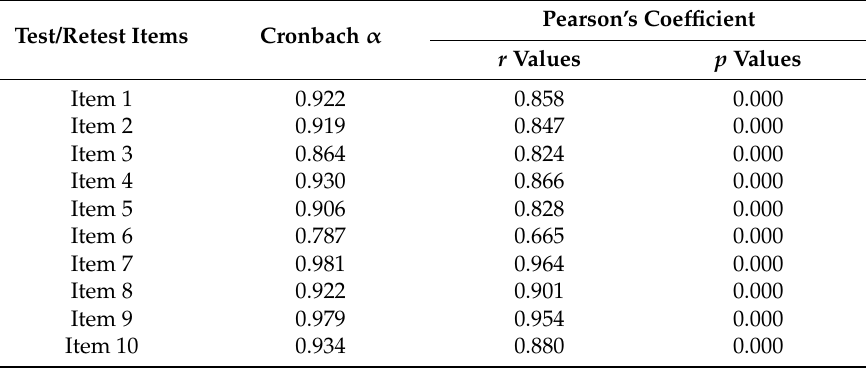
Table 2. Test/retest internal consistency (Cronbach α ) and correlation analysis of the Serbian version of the Dysfunctional Voiding Symptom